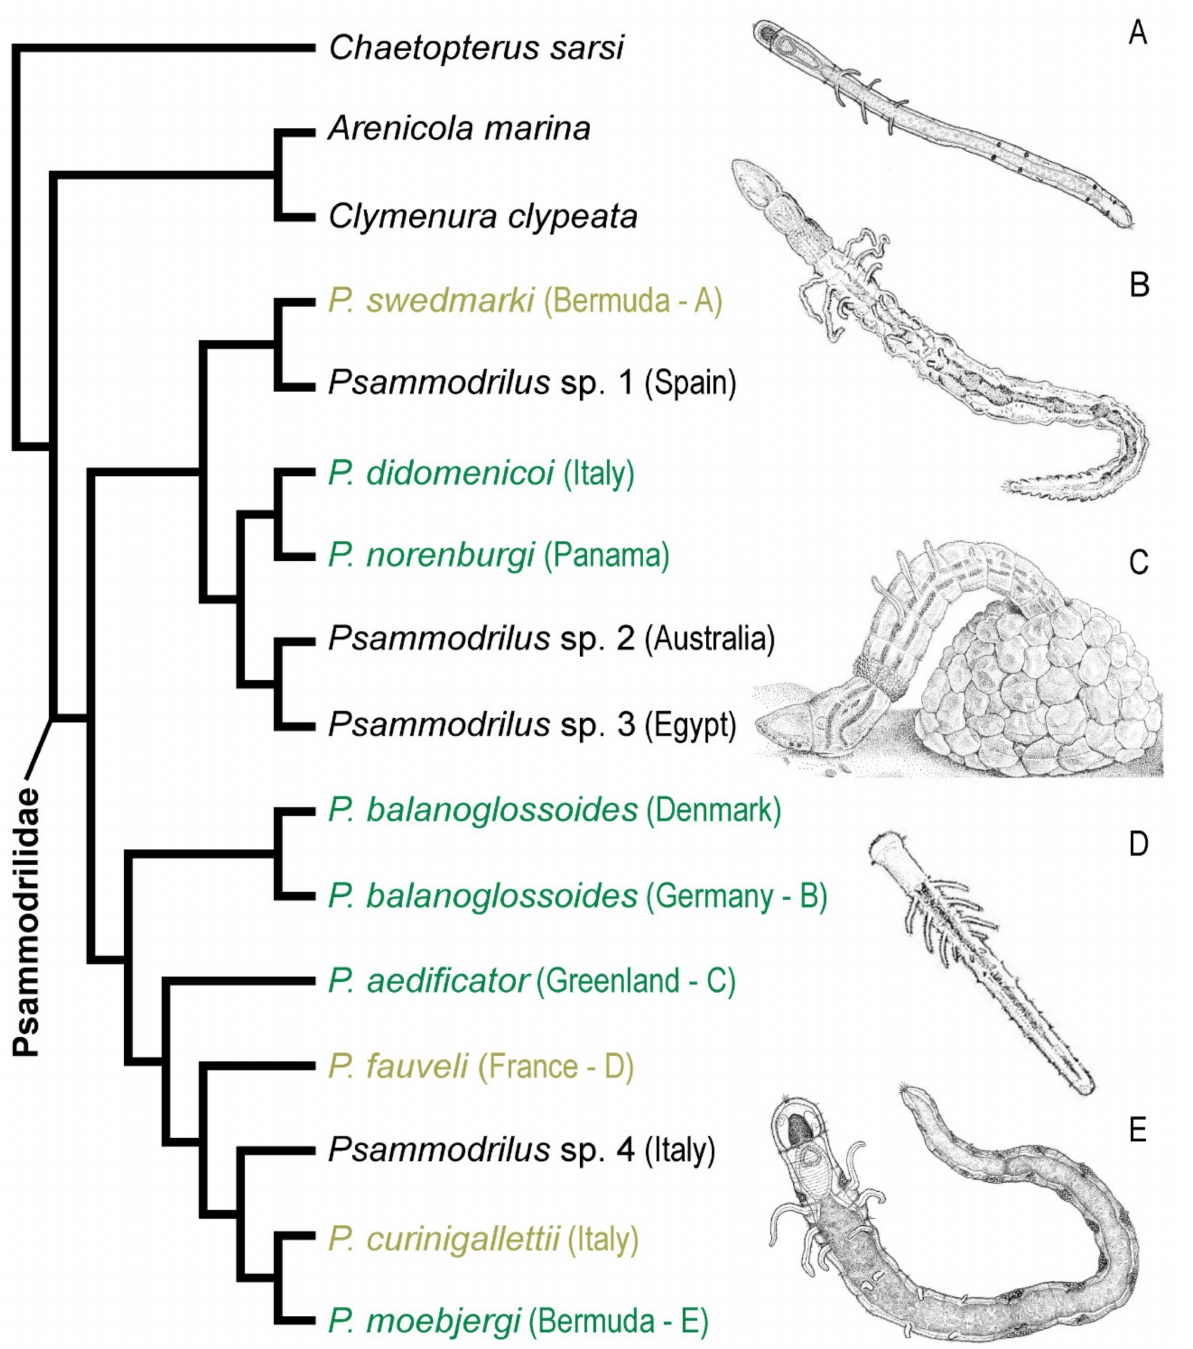
Figure 13. Phylogenetic tree of Psammodrilidae based on direct optimization parsimony analyses of combined molecular and morphological data (modified from [21]). Small-sized, collar-lacking species in olive green font two of which illustrated in ( A , D ), large-sized species in dark green font three of which illustrated in ( B , C , E ), psammodrilids of unknown size in black